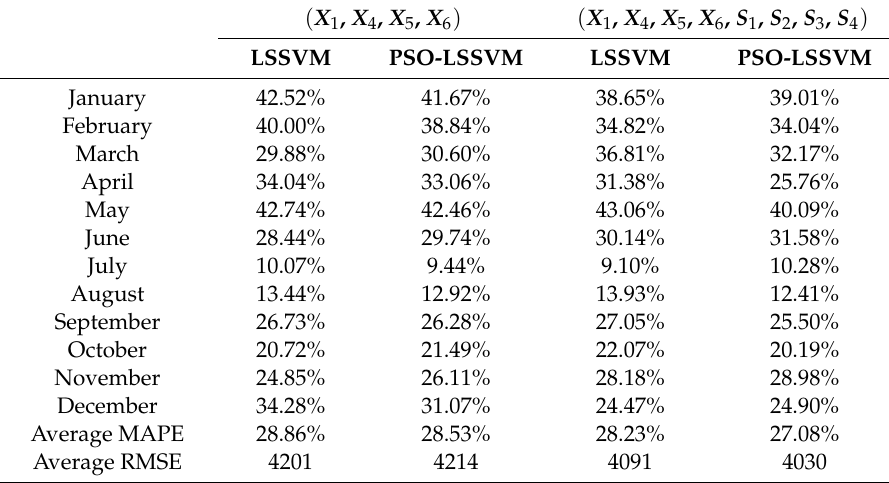
Table 4. Prediction results of PSO-LSSVM and LSSVM with di ff erent sets of